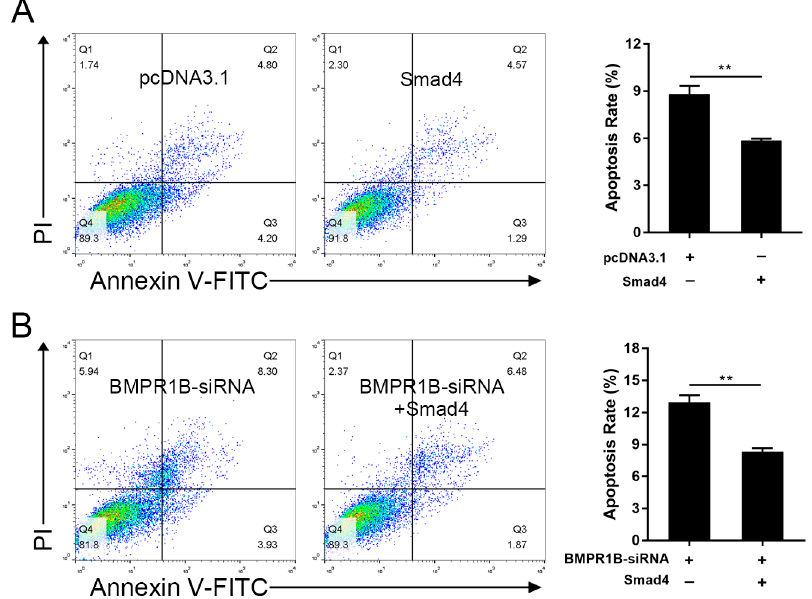
Figure 7. Smad4 regulates BMPR1B-mediated cell apoptosis in the ovine granulosa cells. ( A ) Smad4 suppresses granulosa cell apoptosis. Smad4 expression vector pcDNA3.1-Smad4 was transfected into the ovine granulosa cells cultured in vitro , and fluorescence-activated cell sorting (FACS) was performed to detect cell apoptosis rate. ( B ) Smad4 inhibits BMPR1B -siRNA-induced granulosa cell apoptosis. pcDNA3.1-Smad4 and BMPR-1B -siRNA were co-transfected into the ovine granulosa cells cultured in vitro , and FACS was performed to detect cell apoptosis rate. Bars represent the mean ± SEM of at least three repeats. ** p <